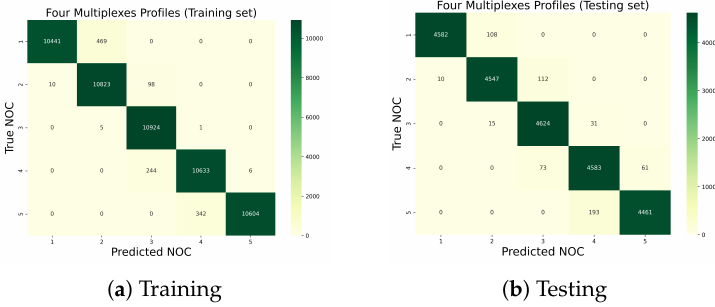
Figure 25. TAWSEEM: confusion matrix (four multiplex profiles).